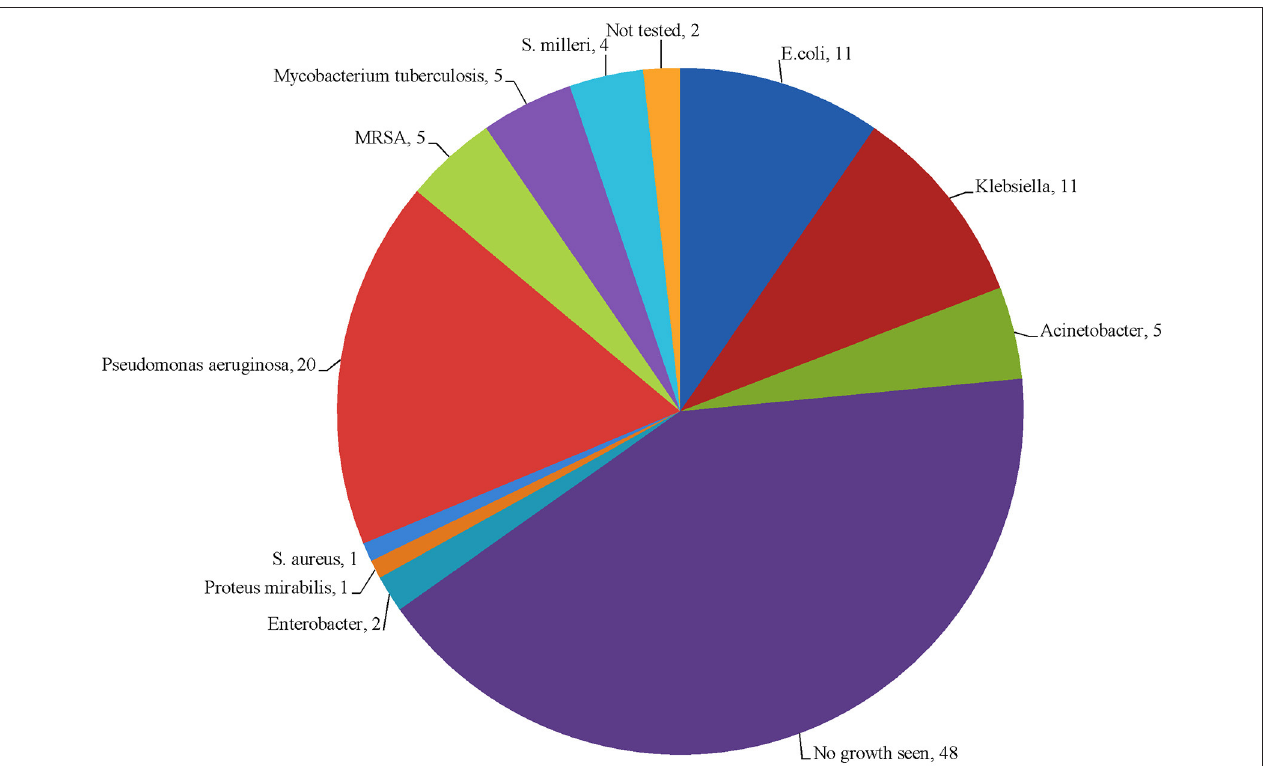
FIGURE 2 | Number and type of bacterial species identified in the